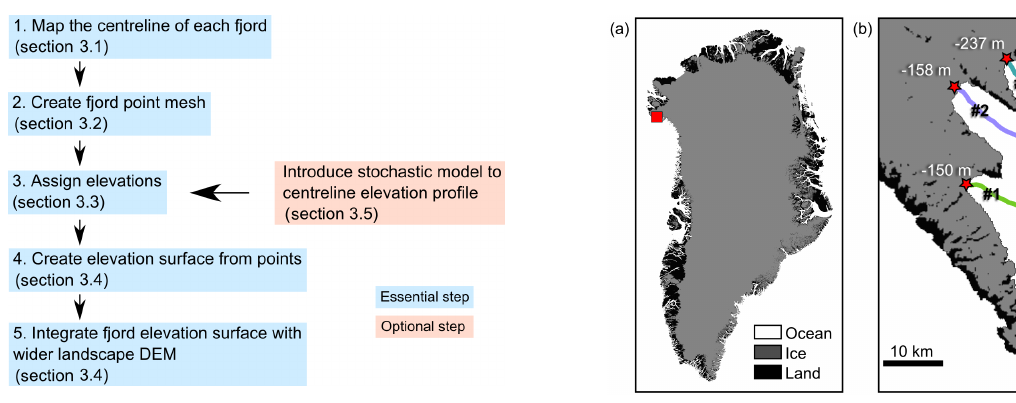
Figure 2. Algorithm flow diagram. Figure 3. (a) The Cape York area of interest in north-west Green- land (red box – zoom displayed in b ) relative to the Greenland land classification mask (Morlighem et al., 2014). (b) The fjord system area of interest with mapped channel centrelines and seed (red star) and mouth (yellow square) elevations as identified from observa- tions (OMG Mission,